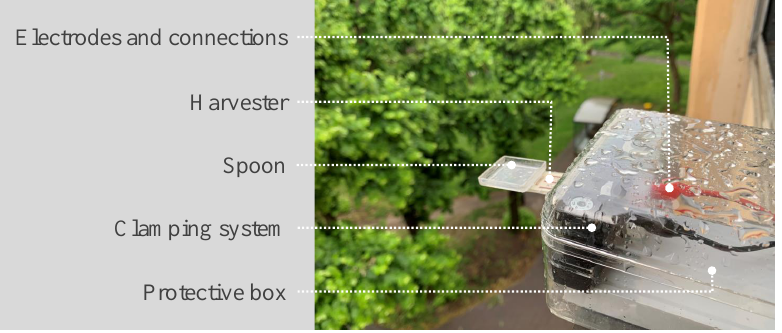
Figure 1. Prototype of the raindrop harvester with spoon in an outdoor test with ’empty